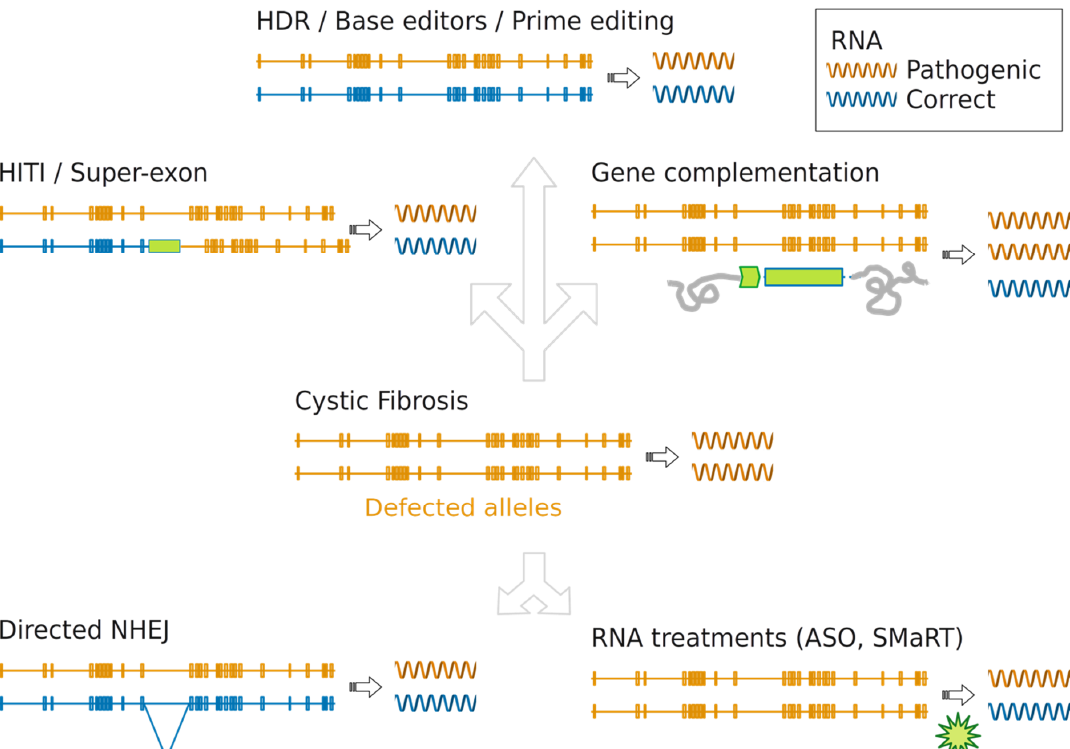
Figure 1. Gene therapy strategies to restore CFTR function in CF. CFTR genes containing any mutation causing cystic fibrosis are colored in orange, genes bearing the correct sequence in blue. Elongated bars indicate the 27 exons distributed over the entire length (188702 bp) of CFTR gene. Striped right arrows indicate the transcription process. In the center panel a typical CF patient condition is depicted; a genetic defect is present on each allele preventing transcription of suitable amount of mRNA molecules with correct sequence. In the gene complementation panel, green arrow indicates the exogenous promoter randomly integrated into the cell genome (grey lines) and able to produce mRNA with correct sequence (blue) in amount su ffi cient to restore CFTR function. Genome editing strategies able to correct at least a copy of the CFTR gene at the endogenous locus. Graphical representation for the HITI and super-exon strategies: targeted gene correction restores specifically the production of correct mRNA molecules (always in blue). Directed NHEJ is also able to reestablish production of correct mRNA molecules for certain splicing defects thanks to small changes introduced in specific intron regions. RNA treatments intervene (green arrow) during the transcription process to rectify correct mRNA molecules production. Table 1. Genome editing techniques applied in CF models and main reported